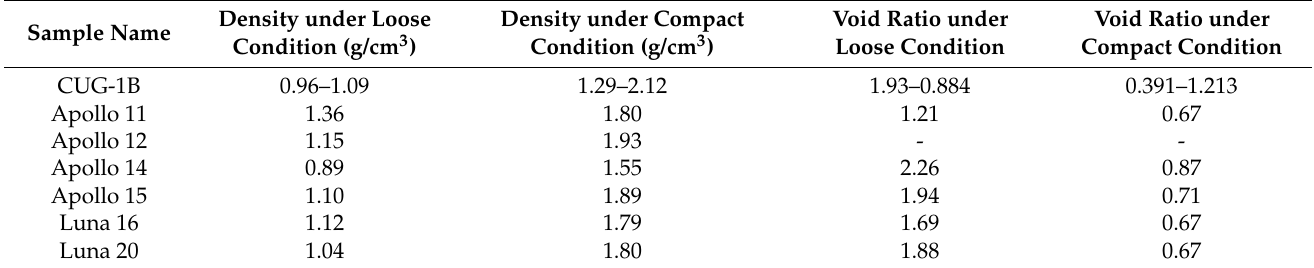
Table 3. The lunar soil simulant’s density, relative density and void ratio.